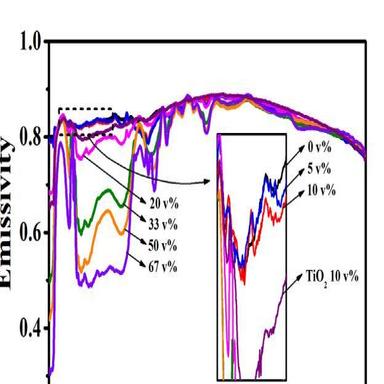
Thermal emissivity spectra of PVC films, PVC porous films and PVC/TiO2 composite films.